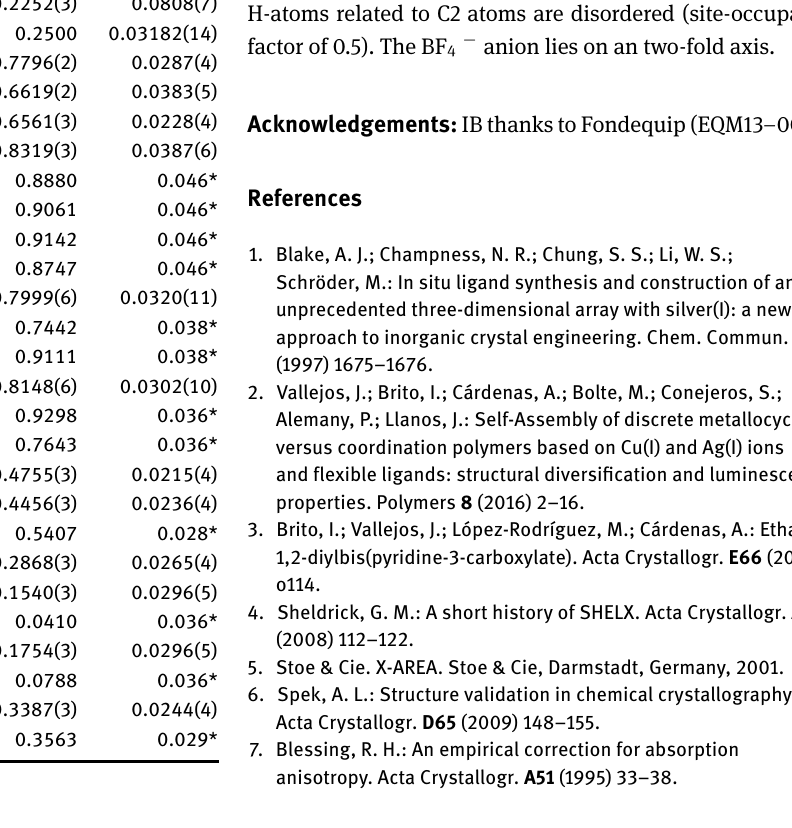
are formed. Weak interactions are observed between F and Ag atoms. The most obvious difference between the ligand of the title compound and the uncoordinated ligand [3] is the angle between the planes of pyridine rings (24.73(11)° and 44.71(19)°) respectively, which is a consequence of the flexible organic components of the title compound. The C3 atom and H-atoms related to C2 atoms are disordered (site-occupancy factor of 0.5). The BF 4 − anion lies on an two-fold